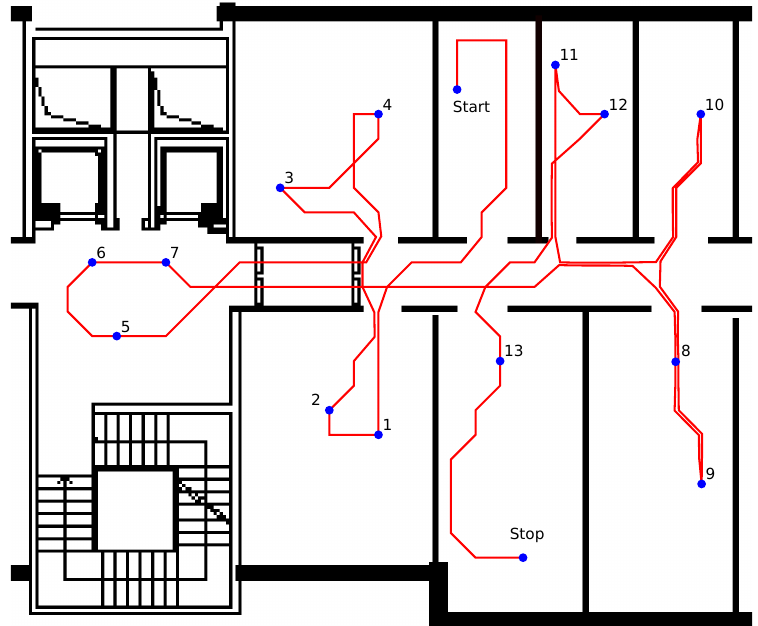
Figure 2. The path performed by the actor in the indoor localization scenario. The points indicated with numbers represent the positions in which the actor stood still for 10